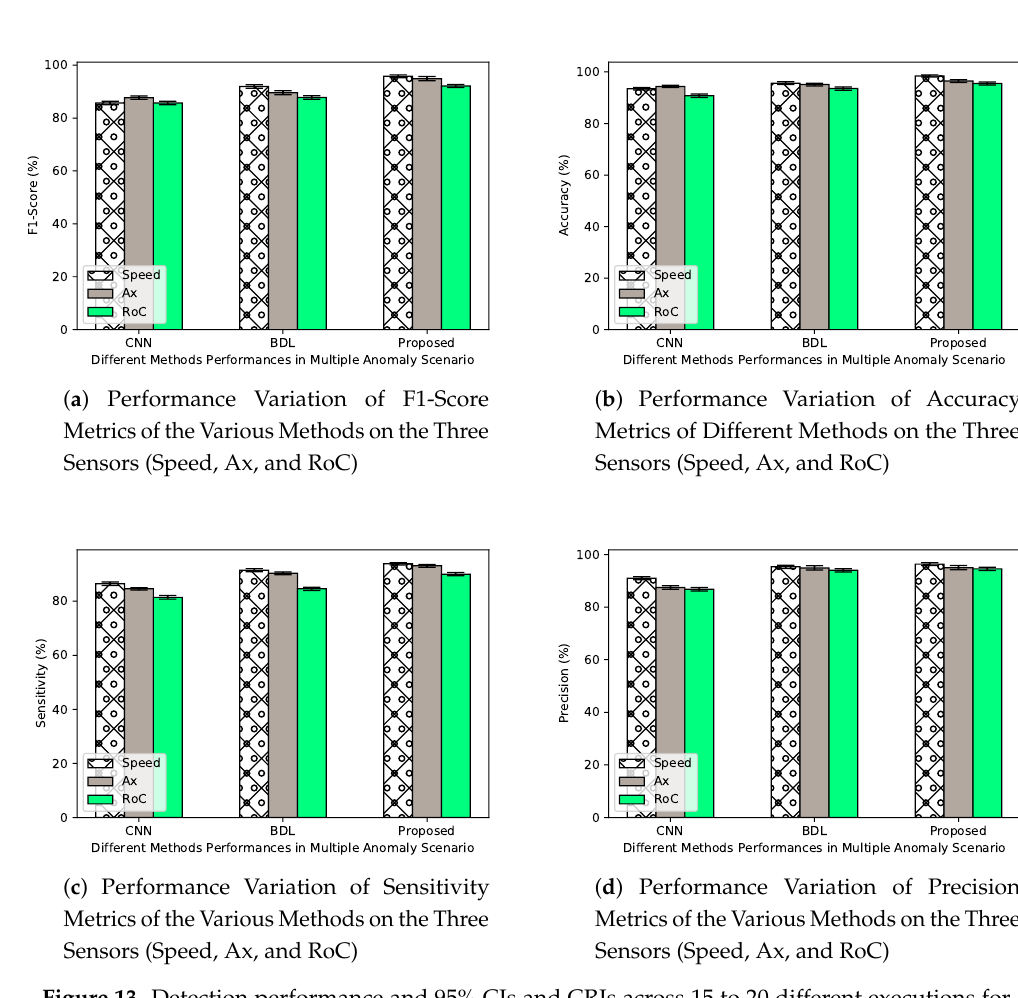
Figure 13. Detection performance and 95% CIs and CRIs across 15 to 20 different executions for all three methods, at anomaly rate α = 10% an in the presence of all the types of